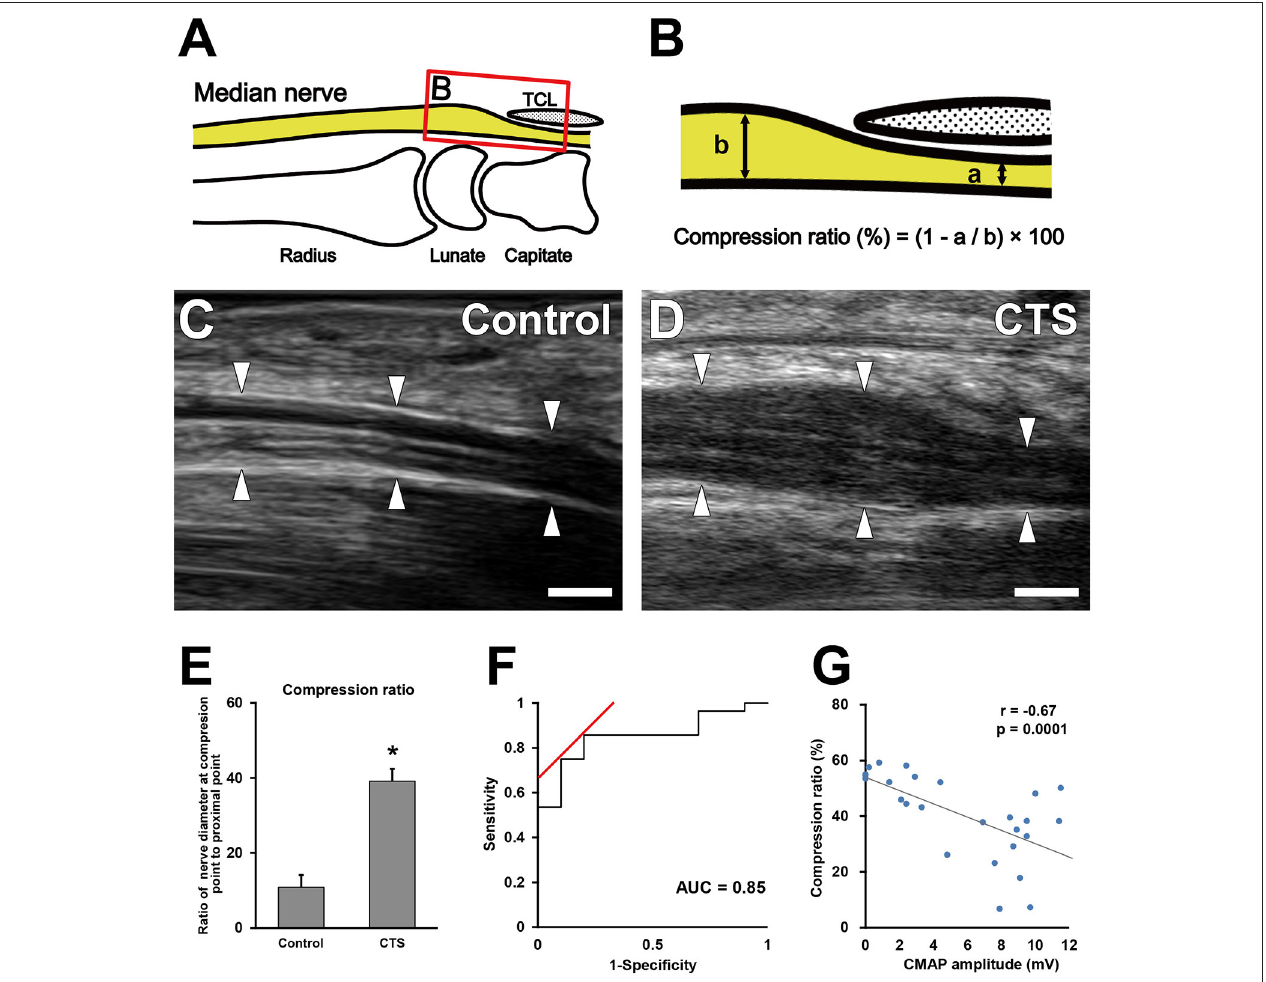
FIGURE 2 | Morphological analysis of the median nerve around the carpal tunnel. Illustration indicates the observed area on ultrasonography (A) . (B) Boxed area in (A) . Quantification of the minimum diameter under the transverse carpal ligament (a) and the maximum diameter around the inlet of the carpal tunnel (b). Ultrasonography of the median nerve in the control (C) and carpal tunnel syndrome (CTS) (D) groups. Arrowheads indicate the outline of the median nerves. Scale bars: 2mm. Quantification of the nerve compression ratio (E) . * P < 0.05, Student’s t -test. Data are presented as mean ± standard error of the mean. Receiver operating characteristic curve for the median nerve compression ratio (F) . Correlation between the extent of nerve compression and electrophysiological severity (G) . Gray line indicates the regression line. The Pearson correlation coefficient = −